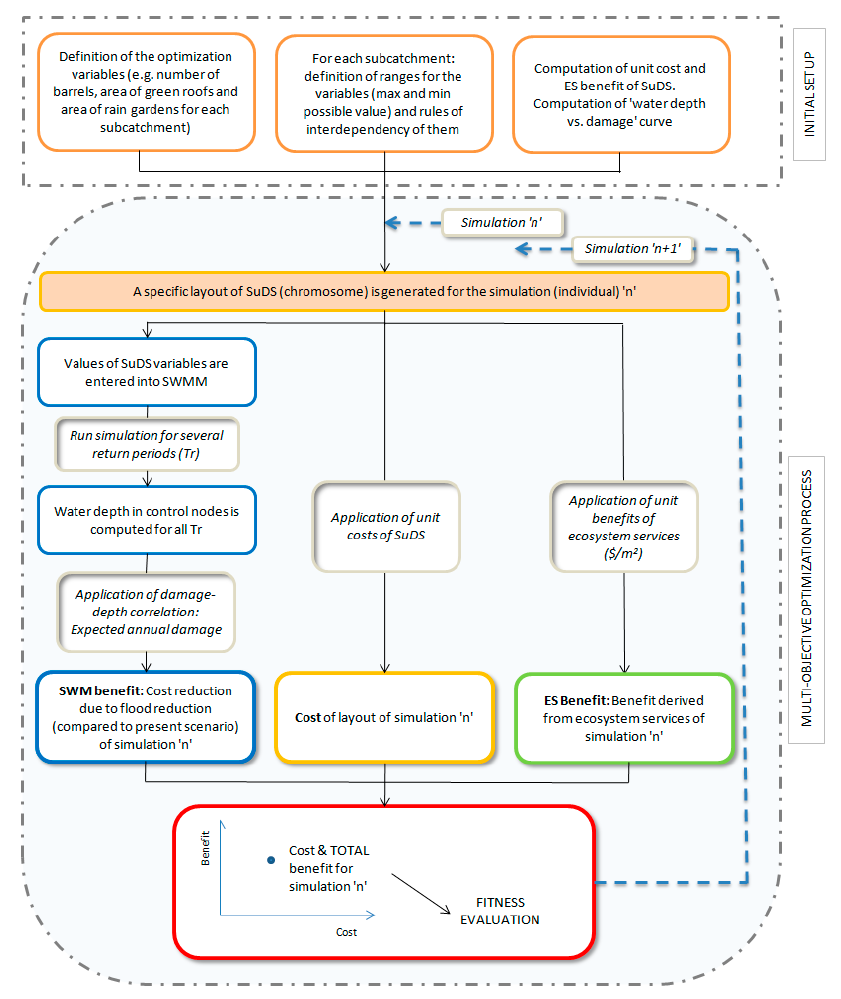
Figure 4. Optimization process framework.